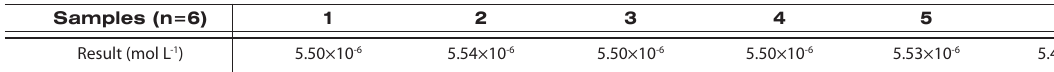
Table 5. The determination results of Eu 3+ of groundwater samples.